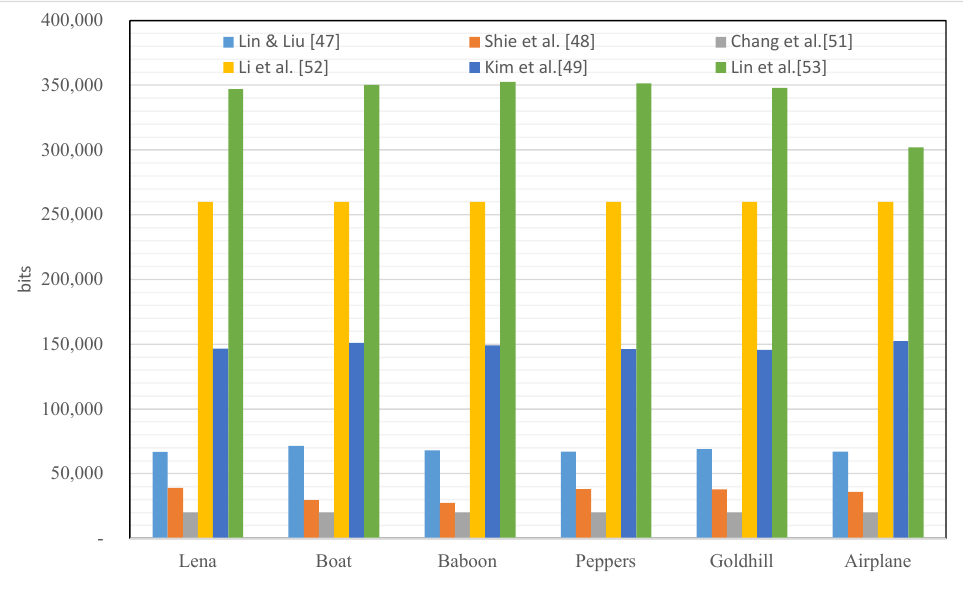
Figure 9. Comparisons of EC performance among existing RDH